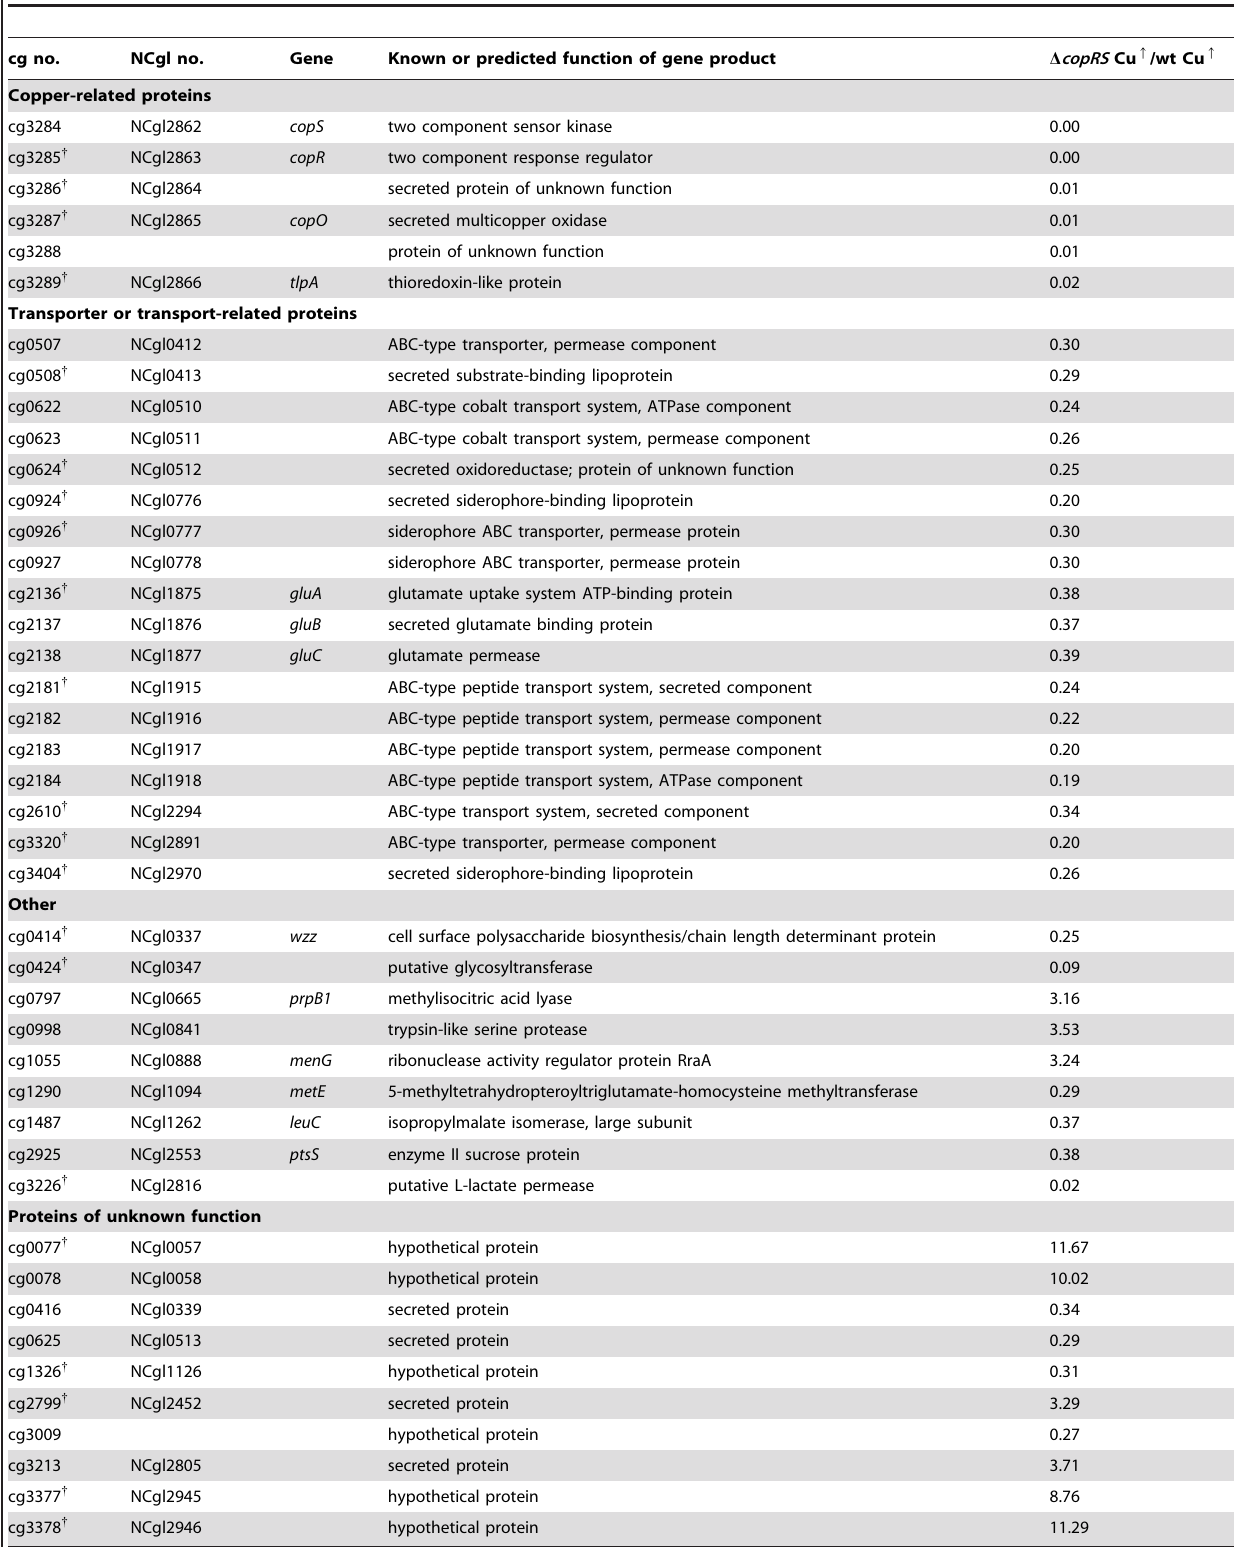
Table 2. Transcriptome comparison of C. glutamicum wild type (wt) and the D copRS deletion mutant after cultivation in CGXII minimal medium supplemented with 21.25 m M CuSO 4 (Cu q ) using DNA microarrays.